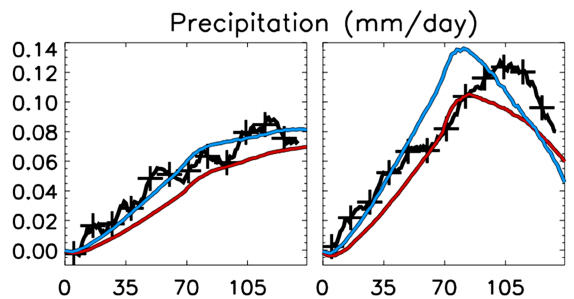
Figure 4. Finding non-linear responses in transient-forcing experi- ments (figure from Good et al., 2012). Time series of global-mean precipitation change under two experiments. Left: where CO 2 is increased by 1% per year, then stabilized at 2 × pre-industrial lev- els. Right: where CO 2 is increased by 2% per year for 70 years, then decreased by 2% per year for 70 years. Black: GCM. Red: step-response model using the abrupt4xCO2 response. Blue: the abrupt2xCO2